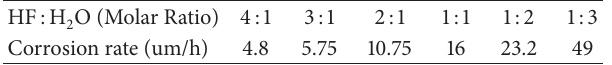
Table 1: Etching rate of HF solution with different